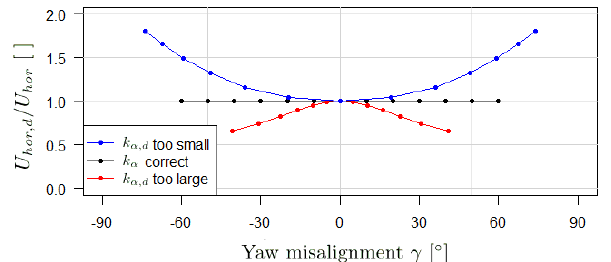
Figure 2. Effect of three k α values on yaw misalignment and wind speed measurements. Black line shows data where the k α is correct (equal to 1 for our theoretical spinner model). Blue curve shows k α set to 0.5. To correct the blue curve to the black curve, the cor- rection should be made with F α > 1 ( F α = 2 in this case). Red line shows k α set to twice the correct value; therefore, we need F α < 1 to correct the measurements to the black